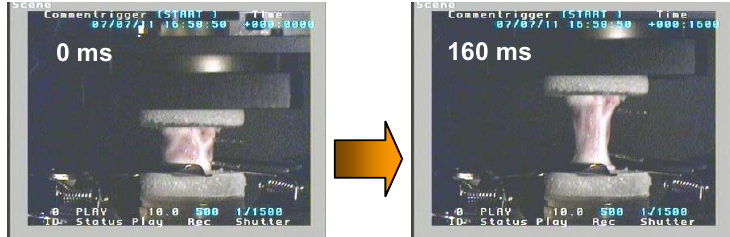
Fig. 3: Typical deformation of brain tissue before (left) and after (right) applying mechanical stretch at the rate of 60 mm/s (4.3 s -1